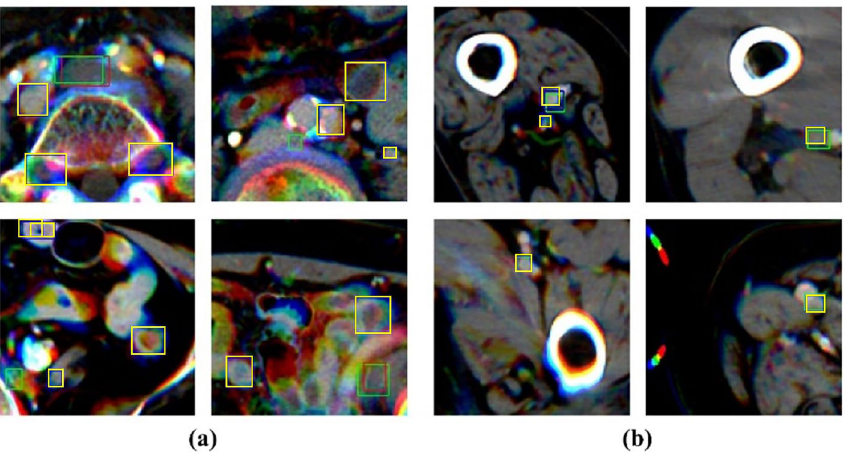
Figure 5. The example of false positive cases image patches from the ResNet50 backbone-based mode with three slices data. The green rectangle box indicates the ground truth, and the yellow rectangle box indicates FP results. (a) represents the cases of the wrong detection and (b) represents the cases of success for localization but failure to